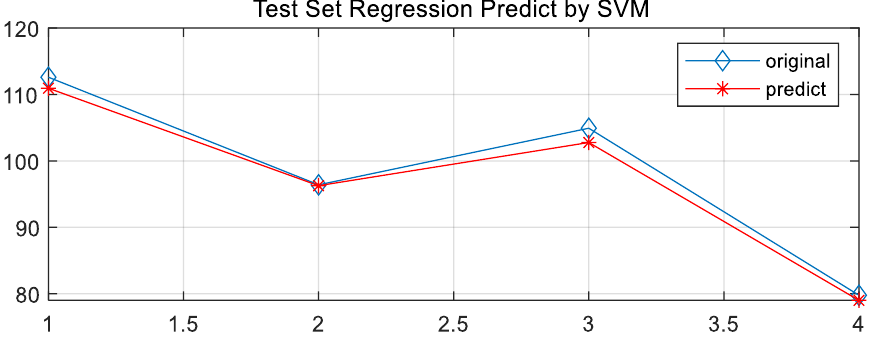
Figure 13. GA(cg)-SVM test set data fit.